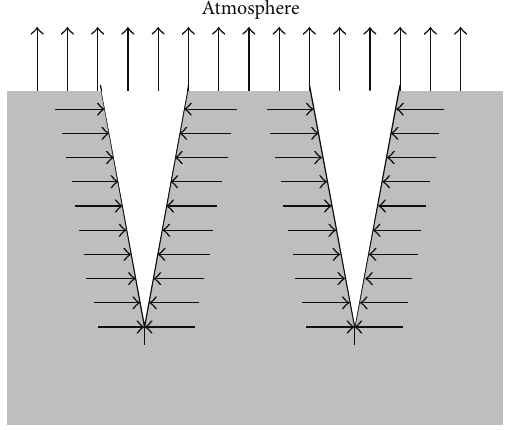
Figure 2: Moisture evaporation model of soil with fissures.